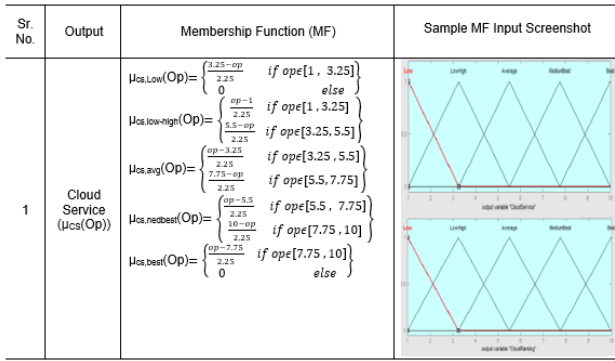
Table 6. Mathematical & Graphical MF of AFIS